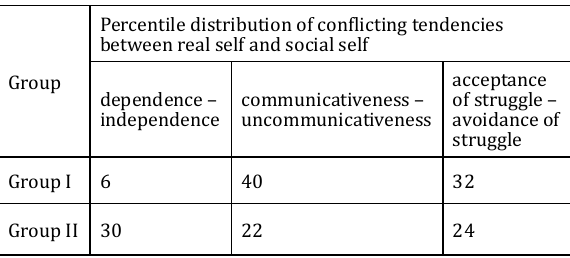
Table 3. Distribution of high rate of conflicting tendencies as per Q-sorting method, (%, n=100)